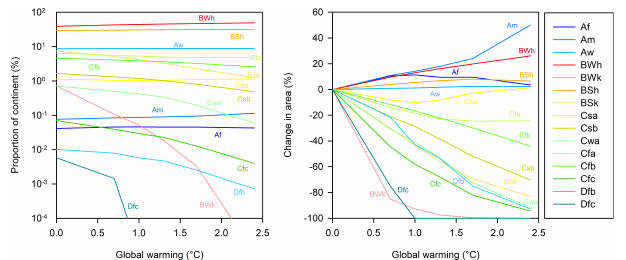
Fig. 6. The proportion of Australia covered by the K¨oppen-Geiger climate types for 5 global warming scenarios and the mode of 17 GCMs and the change in area relative to the historical baseline sce- nario.